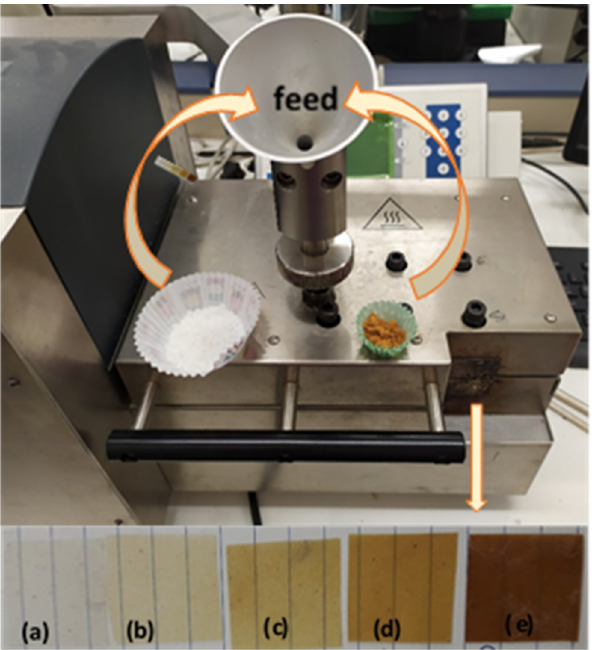
Figure 1. Scheme with the extrusion process used for the preparation of Poly(L-Lactic Acid) (PLLA)/chitosan (CS) and PLLA/CS/BO composites films: ( a ) “blank” PLLA, ( b ) PLLA/CS/BO5, ( c ) PLLA/CS/BO10, ( d ) PLLA/CS/BO20, and ( e ) PLLA/CS/BO30.